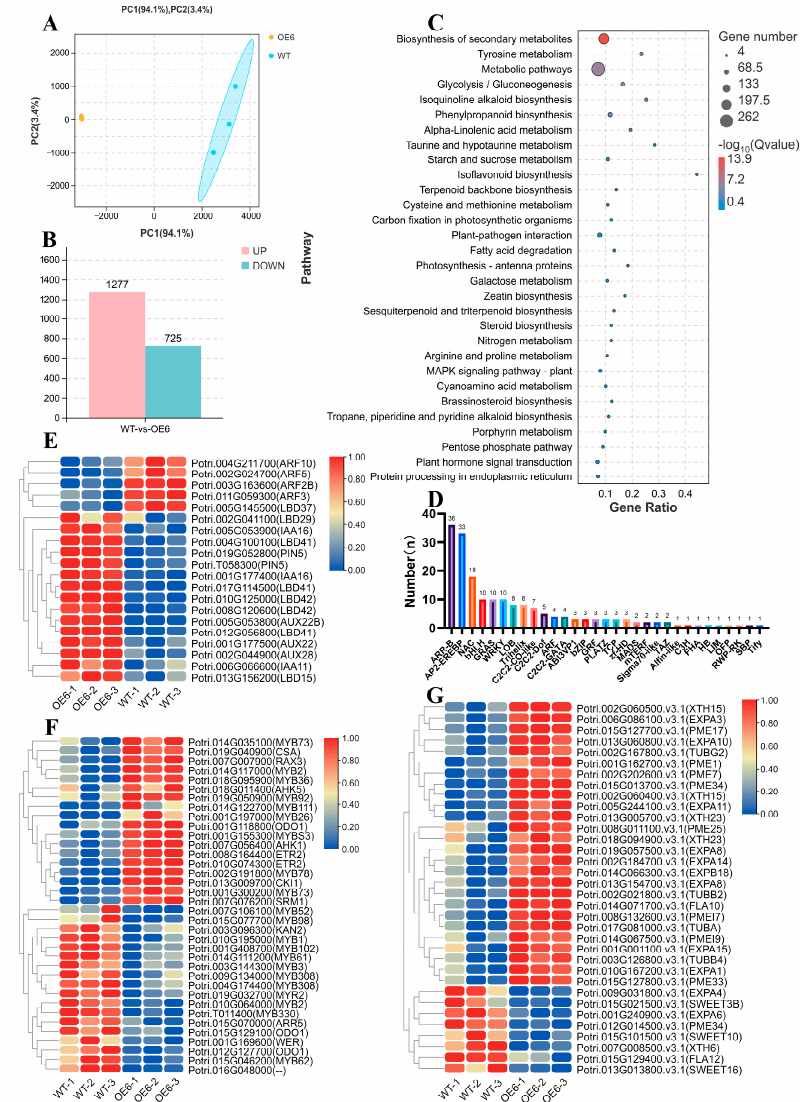
Figure 7. RNA-seq differentially expressed gene analysis. ( A ) Principal component analysis PCA of the expressed genes showing sample separation. Principal component 1 (PC1) and PC2 explaining 94.1 and 3.4% of the total variance, respectively. ( B ) The number of DEGs with upregulated genes in pink and downregulated genes in light blue. ( C ) Kyoto encyclopedia of genes and genomes KEGG. enrichment analysis of DEGs, node color represents -log10 transformed Qvalue—corrected p -Value, node size represents rich factor. ( D ) Number of transcription factors in DEGs. Heatmap of auxin ( E ) and cytokinin ( F ) related genes. ( G ) Heatmap of cell wall development and cell elongation related